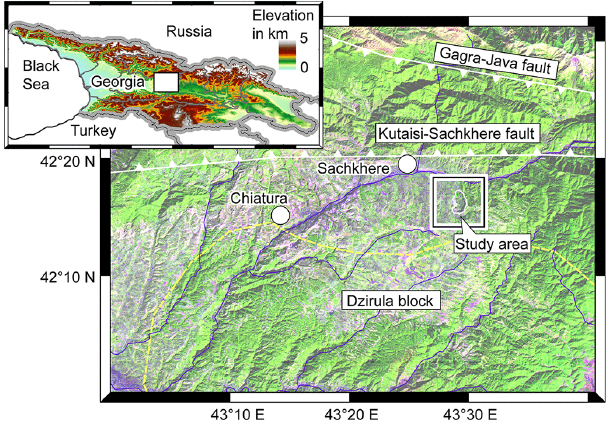
Fig. 1. Map of central Georgia showing land cover based on Landsat TM information. The combination of bands 5, 4 and 3, represented with red, blue and green, respectively, shows vegetation in bright green colours and soil in mauve colours. The violet curves close to Sachkhere and Chiatura show the main path of the Kvirila River. The location of the Itskisi landslide is near Sachkhere. Faults indi- cated by white symbols are thrust faults. The faults were defined by Gamkrelidze (1978).